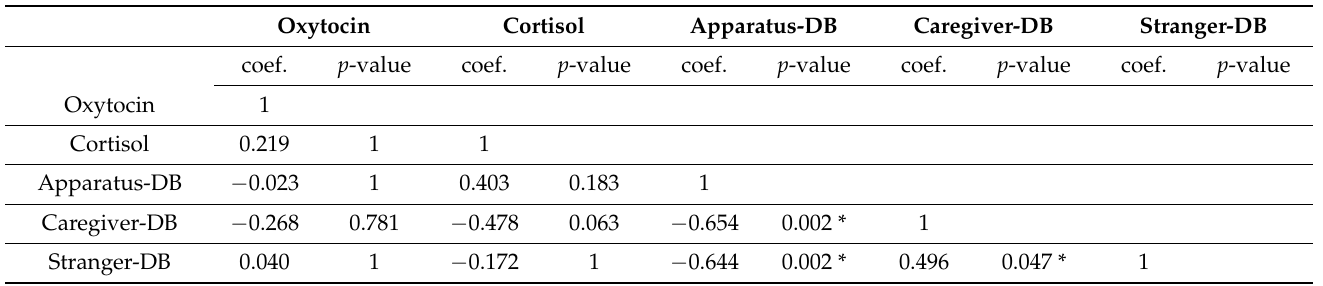
Table 2. Spearman correlations between oxytocin, cortisol, and behavioral variables (duration). Asterisks indicate a significant correlation. Sample size: 25 calves.